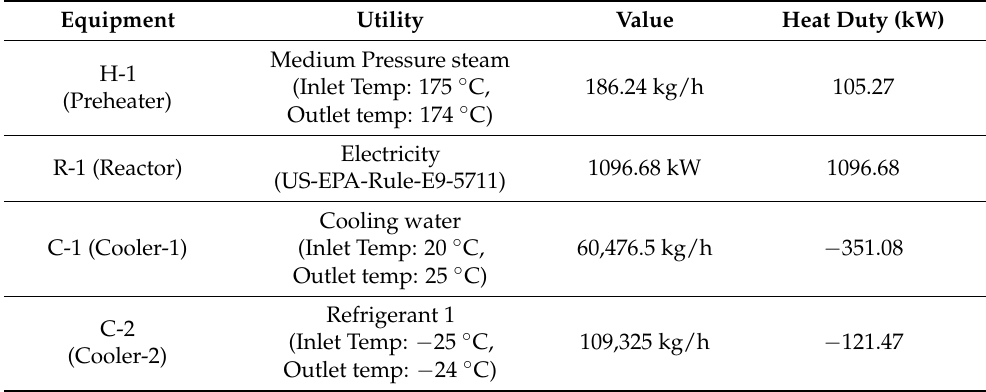
Table 2. Utility data for the pyrolysis